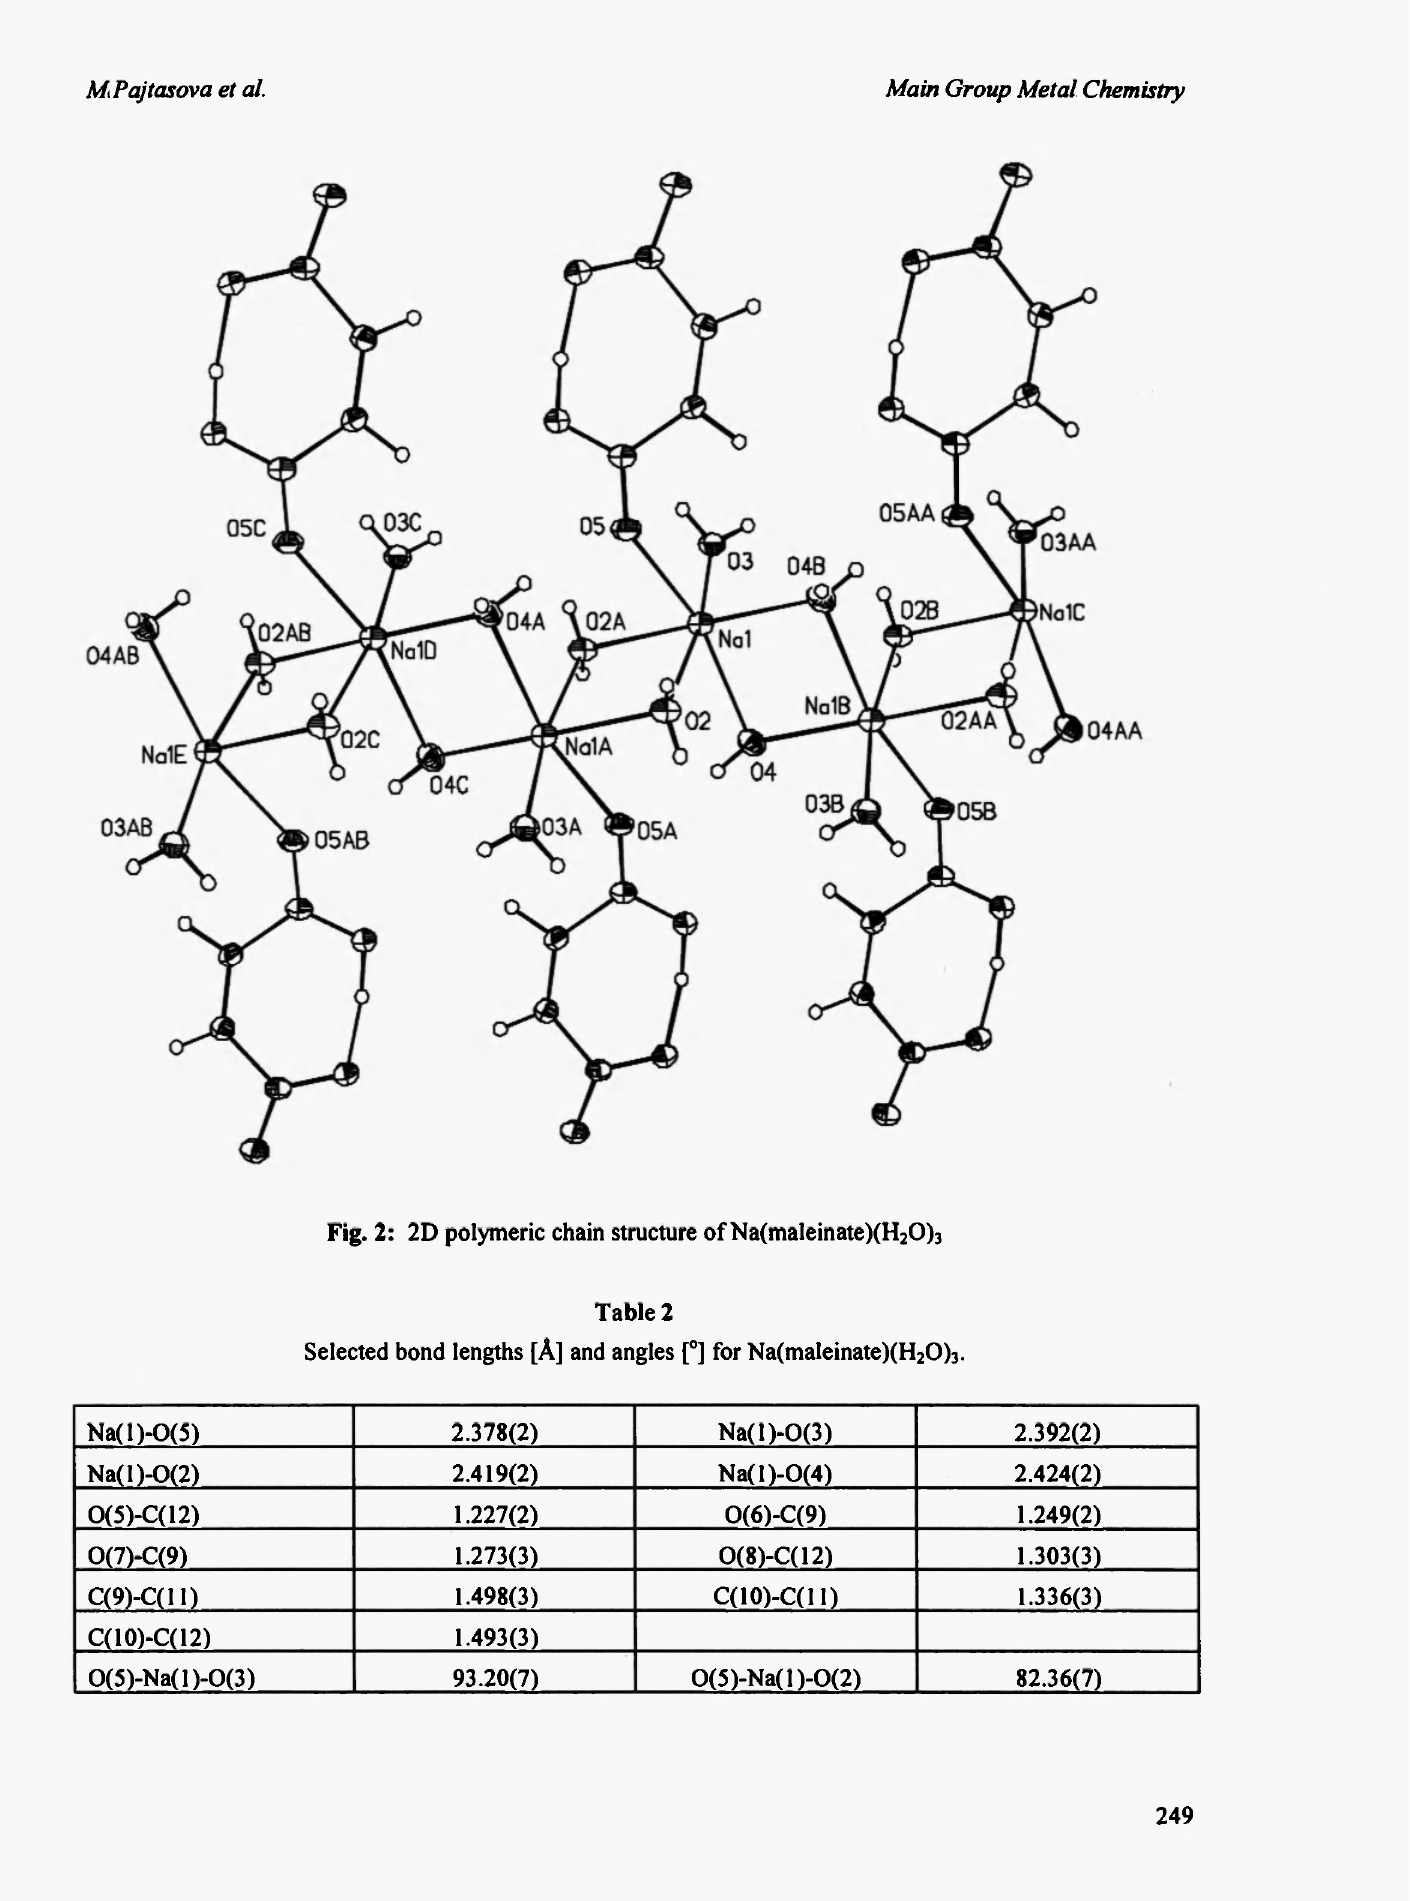
Fig. 2: 2D polymeric chain structure of Na(maleinate)(H 2